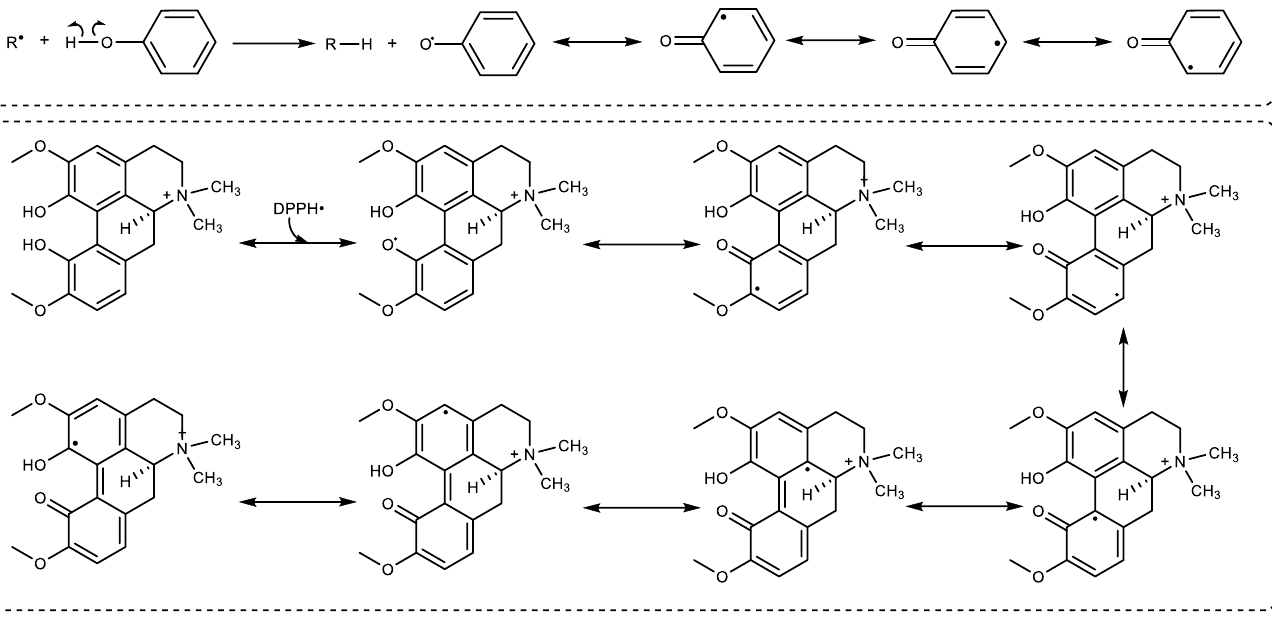
Figure 5. Proposed possible DPPH radical scavenging mechanism of Magnofluorine.